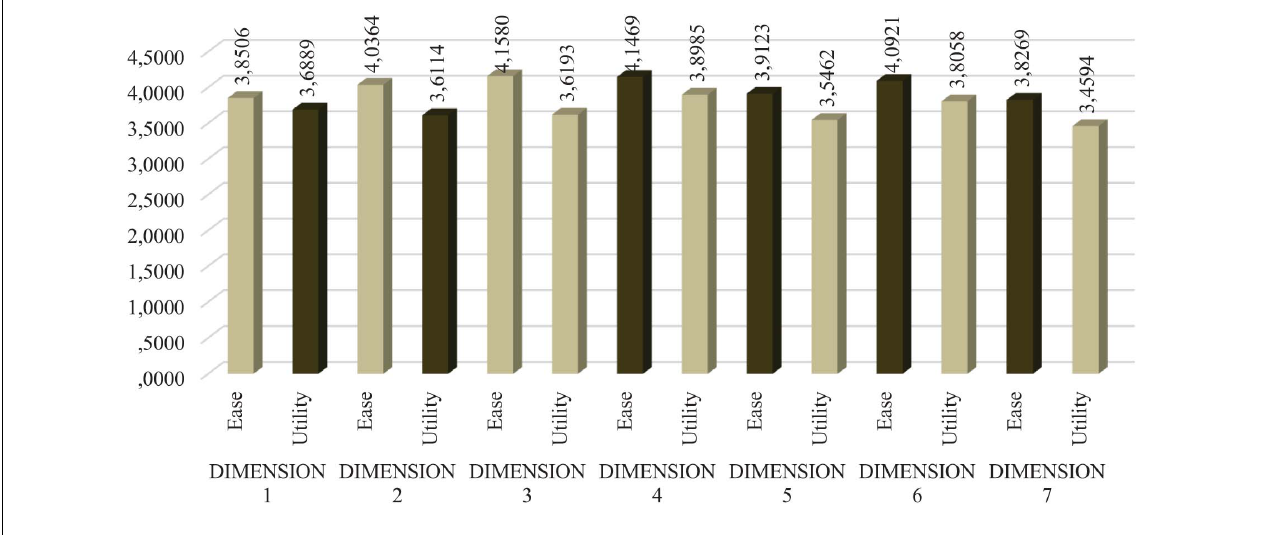
FIGURE 5 | Ease/utility analyzed by dimensions. Source: